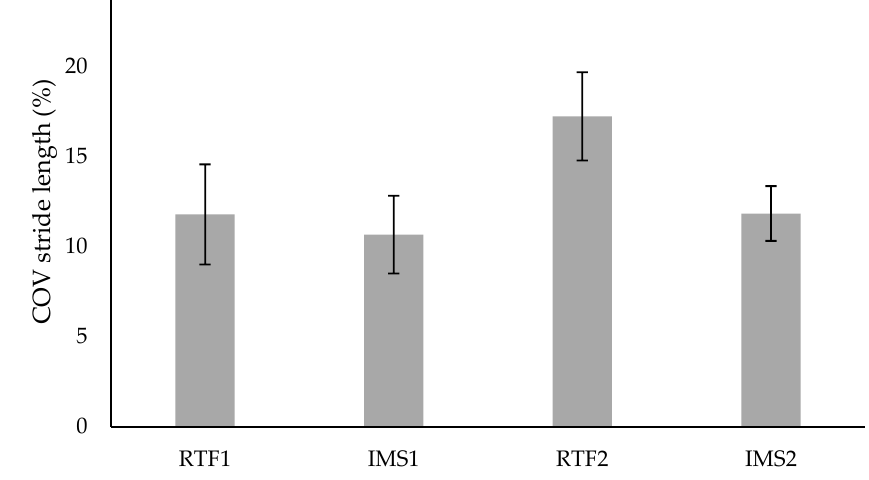
Figure 4. Coefficient of variation (COV) of stride length for SG. Values are means ± standard error. Both mode × time interaction effects, which were found for the variability of stride length and the variability of stride time, are due to an increase of variability from week 1 to week 2 in RTF. However, post-hoc tests did not reveal any significant